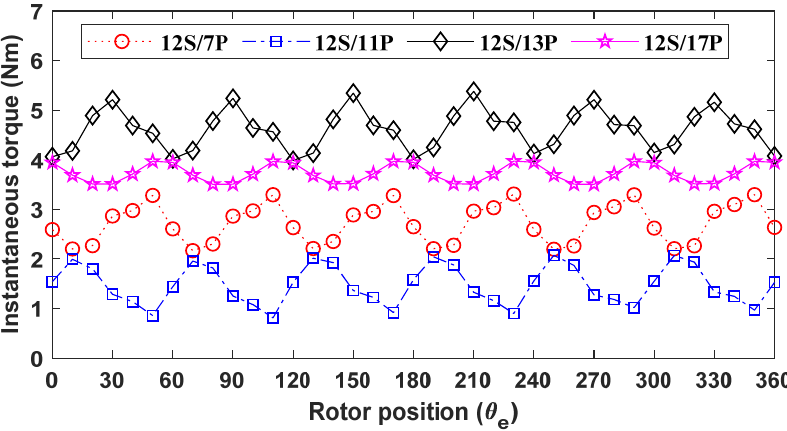
Figure 7. Instantaneous torque profile with rotor pole number. Table 2. Quantitative performance of the OR-FEFSM with various rotor pole numbers at 𝐽 (cid:3028) = 𝐽 (cid:3032) = 15 A/mm (cid:2870) .